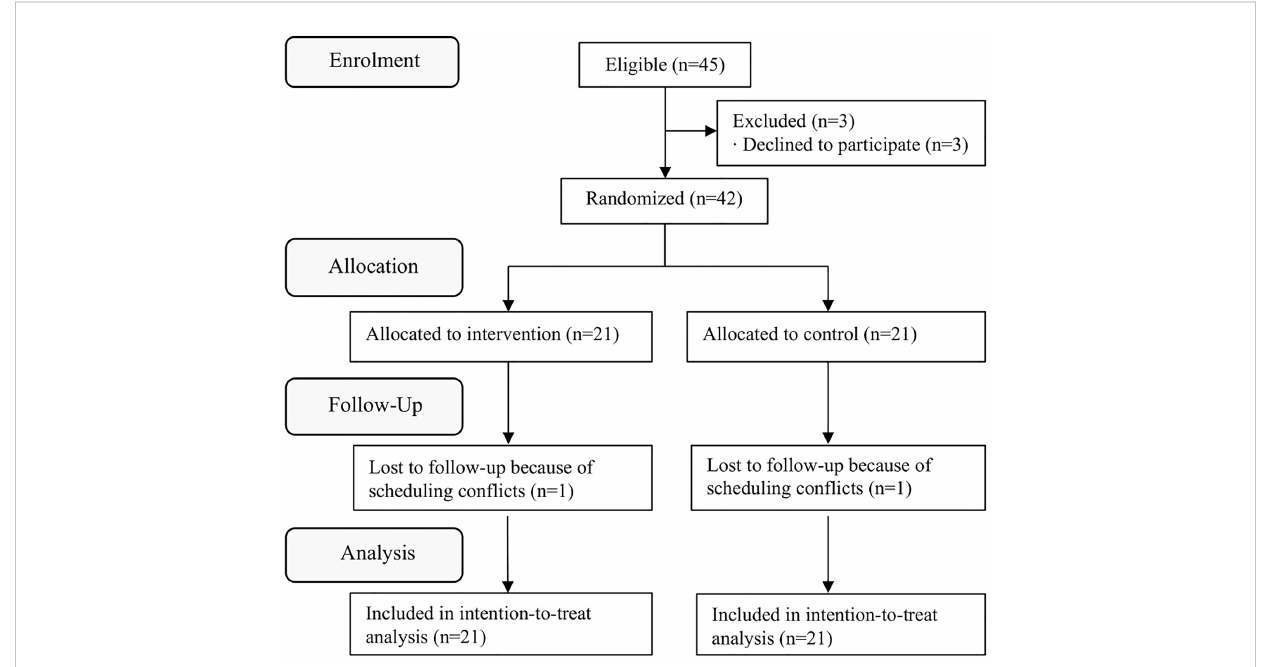
FIGURE 1 Consolidated Standards of Reporting Trials (CONSORT) diagram of study